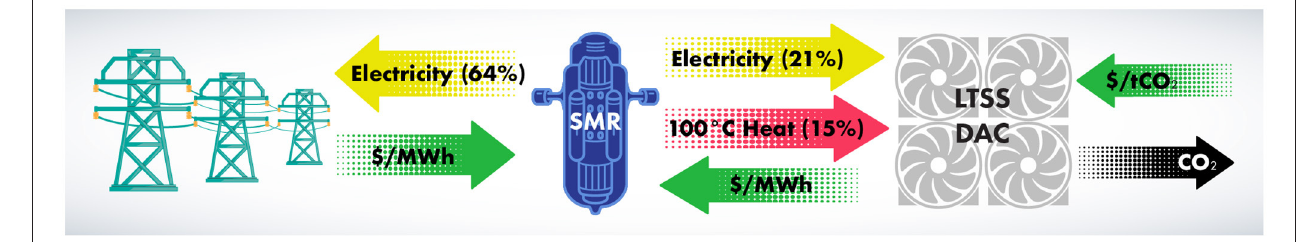
FIGURE 2 | Co-generation scenario.